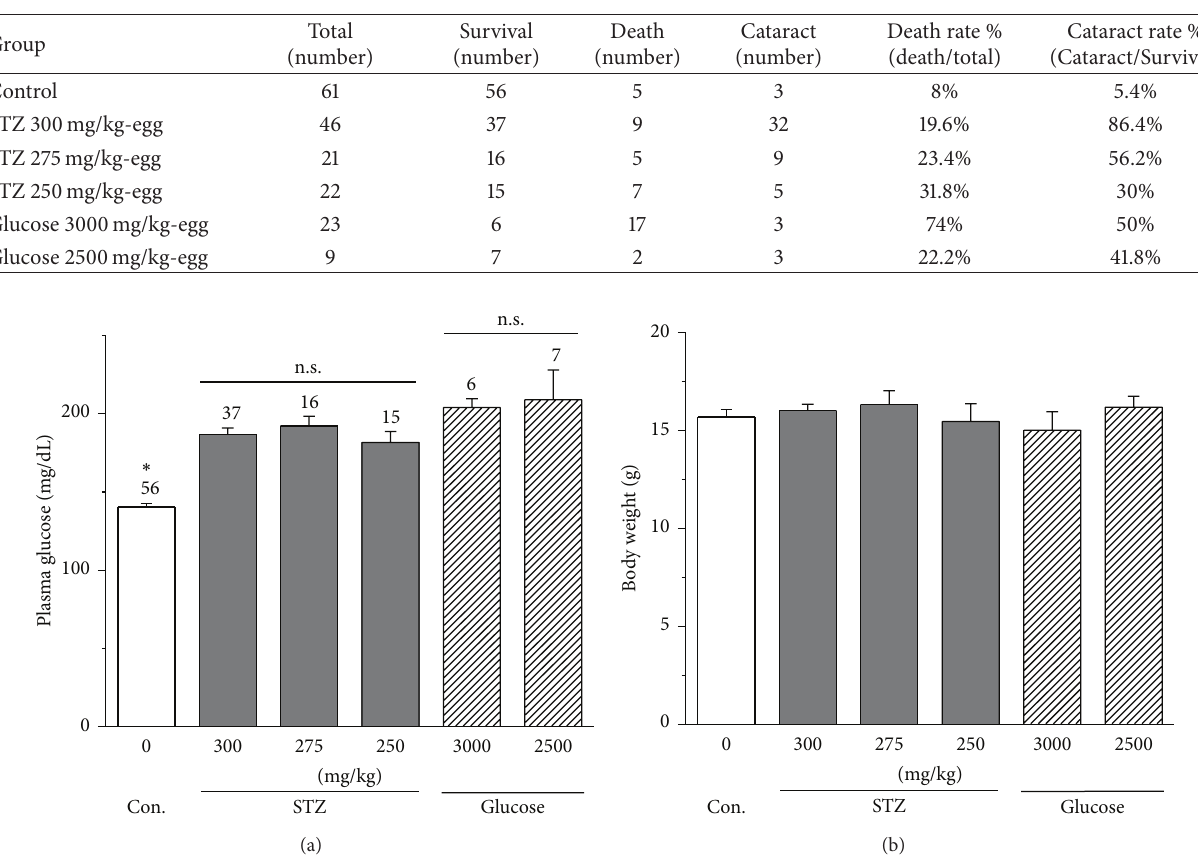
Table 1: The numbers and rates of death and cataract after various STZ or high-glucose injections. Various doses of STZ or high-glucose were injected into the chick embryos at E11, and the data were taken at E18.